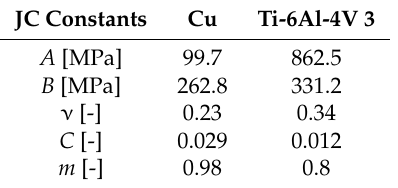
Table 2. Johnson–Cook (JC) constants of copper and Ti-6Al-4V [31,32].